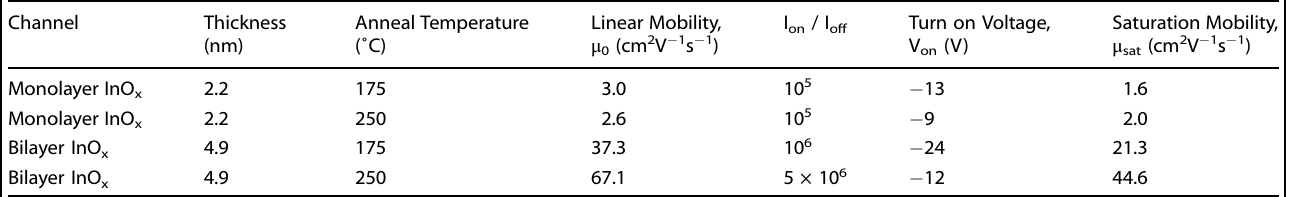
Table 1. Transistor performance summary.